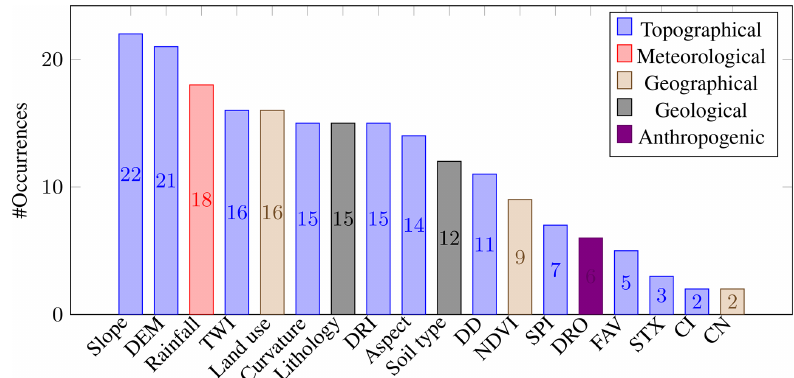
Figure B1. Distribution of the inputs for flood susceptibility for the 23 reviewed papers. The inputs are categorized in topographical, meteo- rological, geographical, geological, and anthropogenic factors. Inputs which were considered only once were discarded from this graph. CI is the convergence index, CN is the curve number, DD is the drainage density, DEM is the digital elevation model, DRI is the distance from rivers, DRO is the distance from roads, FAV is the flow accumulation value, NDVI is the normalized difference vegetation index, SPI is the stream power index, STX is the sediment transport index, and TWI is the topographic wetness